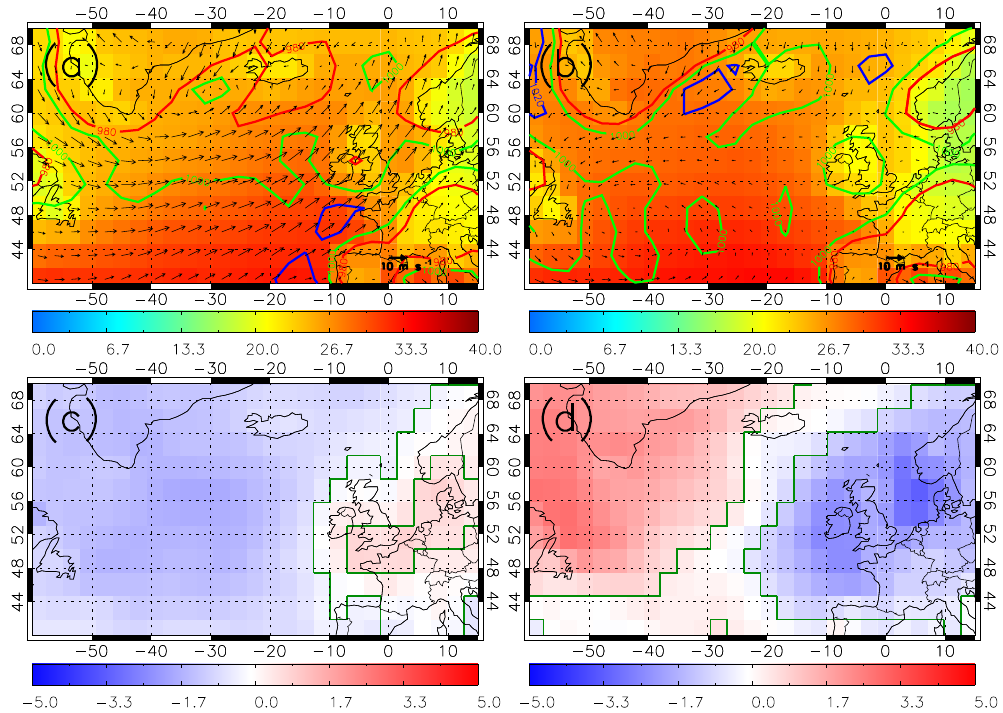
Figure 12. TOMCAT surface ozone (ppbv) averaged between 2006 and 2015 sampled under the wintertime (NDJF) NAO. Panel (a) NAO positive phase, (b) NAO negative phase, (c) shows the NAO positive phase anomaly relative to the wintertime average and (d) shows the negative NAO phase anomaly relative to the wintertime average. Wind vectors show the horizontal 10m winds and the red, green and blue contours represent 980, 1000 and 1020hPa surface pressure. Green polygon-outlined regions in (c) and (d) highlight significant differences at the 95% confidence level based on the